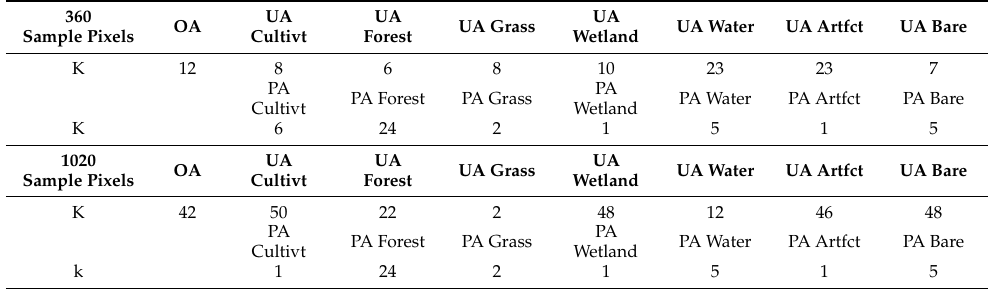
Table A3. Optimum k for k nearest neighbors for local accuracy characterization (method